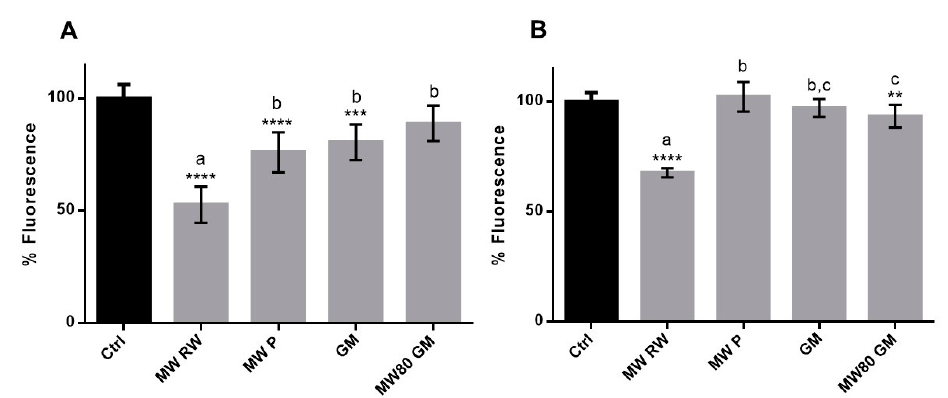
Figure 2. Pre-incubation of cells with 0.25 mg/mL of extracts for 1h – effect on endogenous ROS. ( A ) HaCaT; ( B ) HFF. The symbol * indicates significance relative to the control ( * p -value ≤ 0.05, ** p -value ≤ 0.01, *** p -value ≤ 0.001, **** p -value ≤ 0.0001). Statistical differences ( p ≤ 0.05) between the samples are identified with different letters. MW RW—MW-pretreated red wine lees extract; MW P—MW-